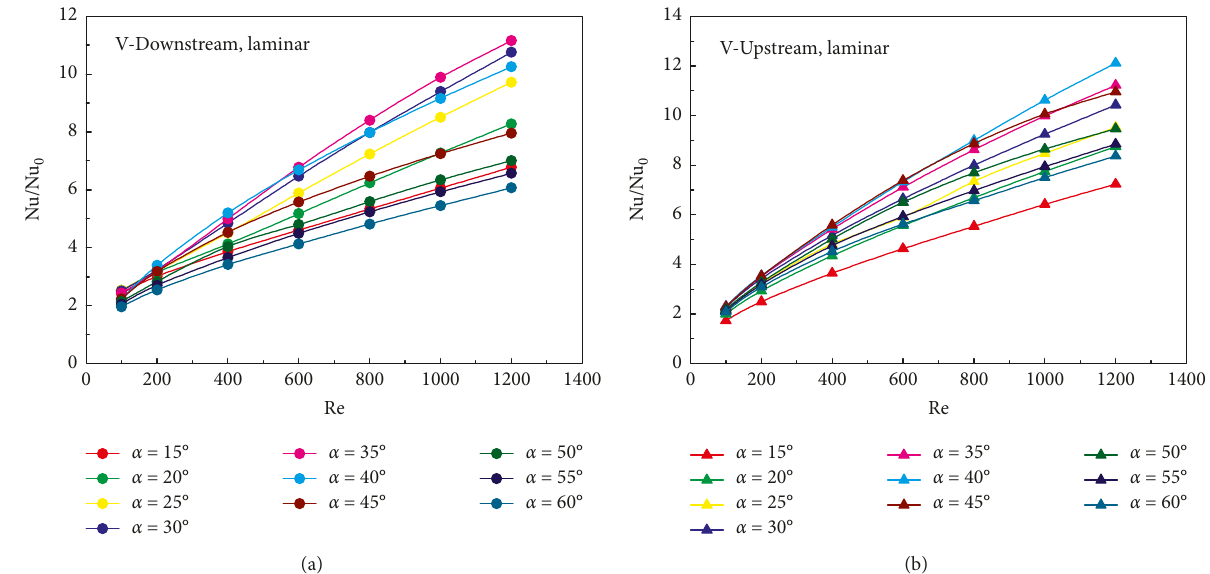
Figure 9: Relations of Nu/Nu 0 with Re for the heat exchanger tube inserted with the V-wavy surface for (a) V-Downstream and (b) V- Upstream at the laminar regime.